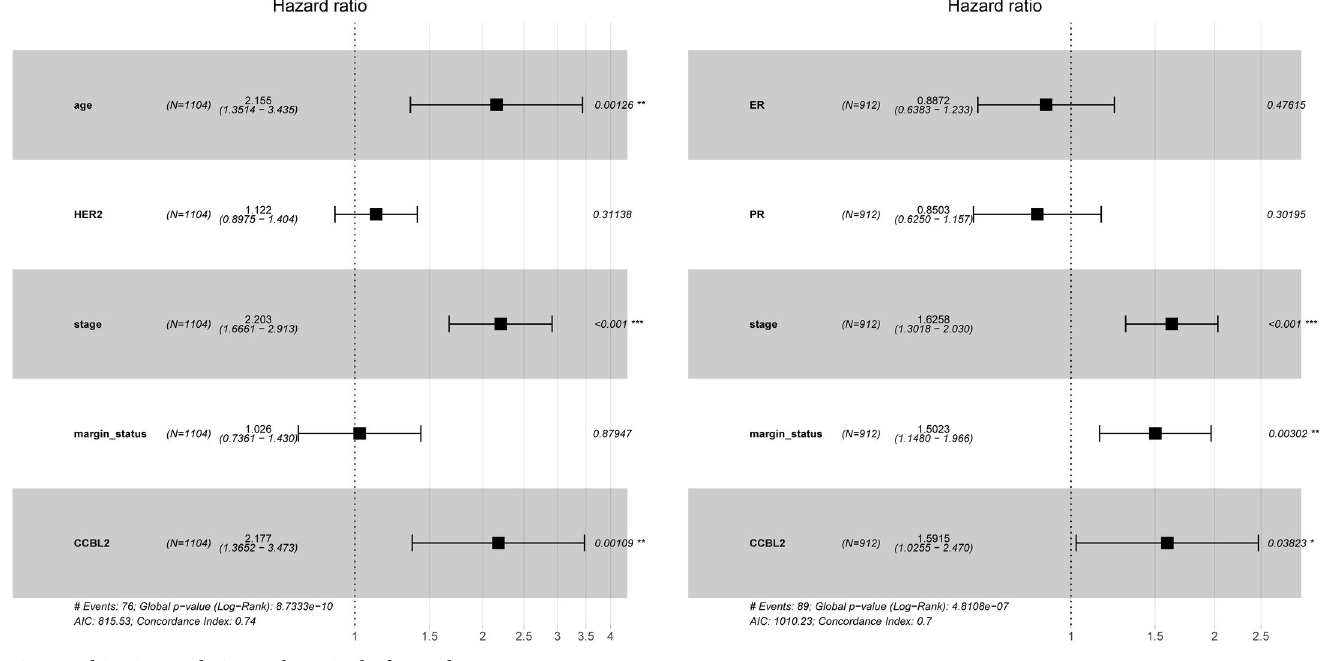
Fig 8. Multivariate analysis was shown in the forest